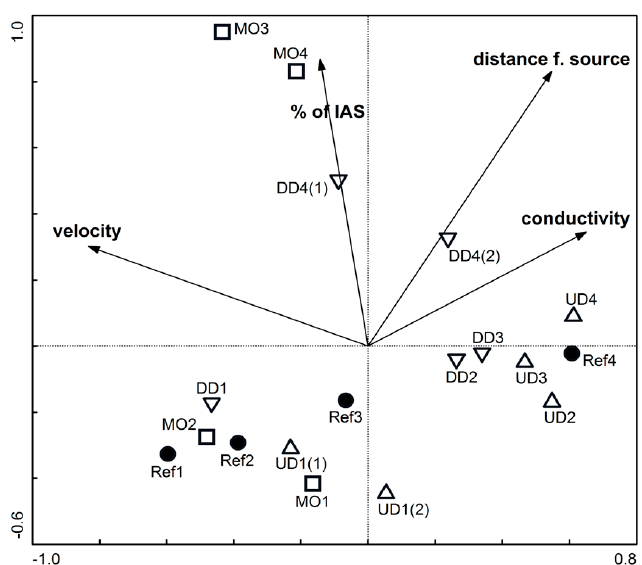
Figure 2. Ordination diagram of the distribution of sampling sites along the significant gradients, according to RDA. The percentage of taxon-environment relation along Axis1 is 57% and along Axis2 is 30.7%. The numbers of the sites increase downstream (see Figure 1B). Circles—reference sites; up-triangles—sites upstream dams; down-triangles—sites downstream dams; squares—most morphologically altered sites.